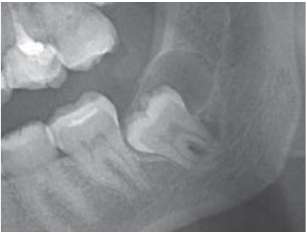
FIGURE 4. Pathology associated with impacted mandibular third molars: Radiograph of dentigerous cyst arising around impacted mandibular third